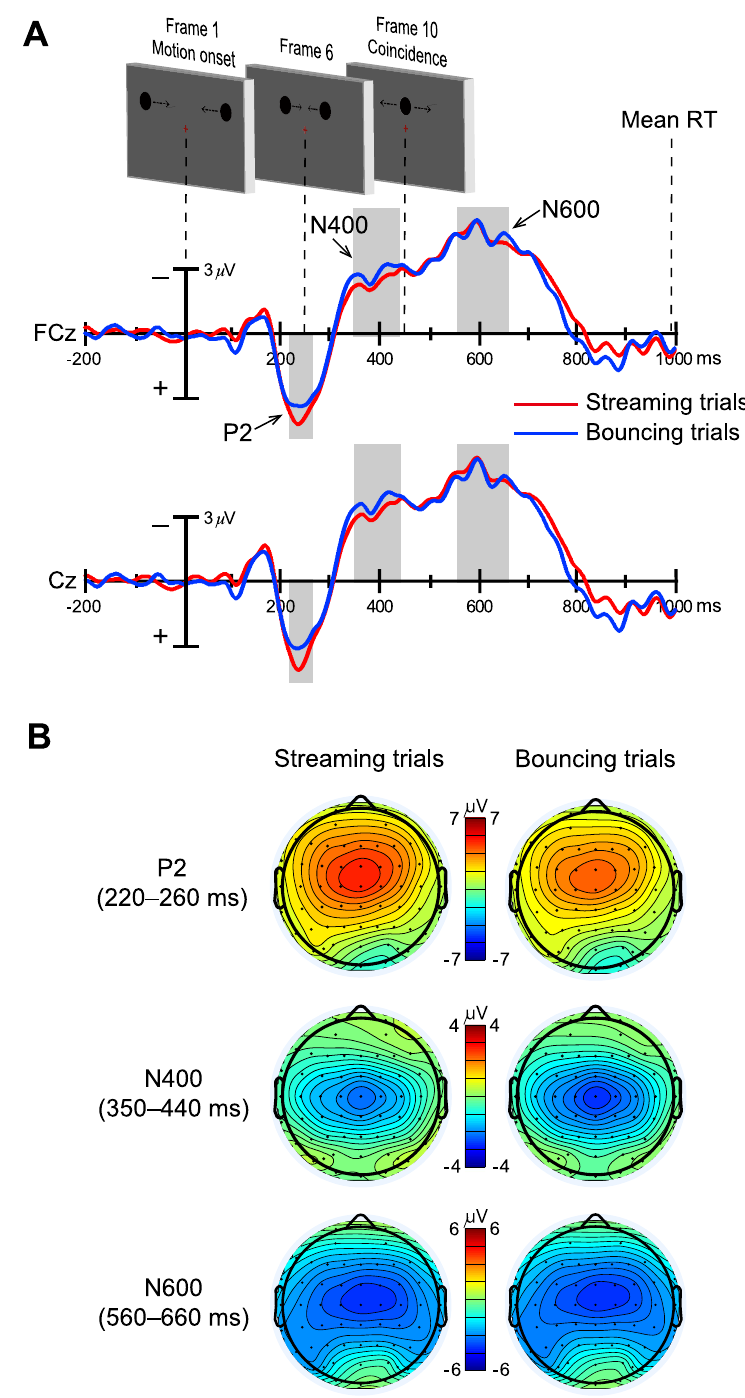
Figure 3. Grand-averaged ERPs associated with the streaming and bouncing percepts over anterior electrodes. ( A ) Three main ERP components over the anterior scalp, P2 (220–260 ms, shaded area, the same below), N400 (350–440 ms), and N600 component (560–660 ms), elicited by the visual streaming/bouncing motion display. Shaded areas show the time windows in which the three components were quantified respectively. Example waveforms shown here are from FCz and Cz electrodes. Key frames from stimuli motion sequences (see Fig. 1 for details) and mean RT (see Fig. 2 for details) are shown above the ERP waveforms. ( B ) Topographical distributions within the time intervals of P2, N400 and N600 for streaming trials and bouncing